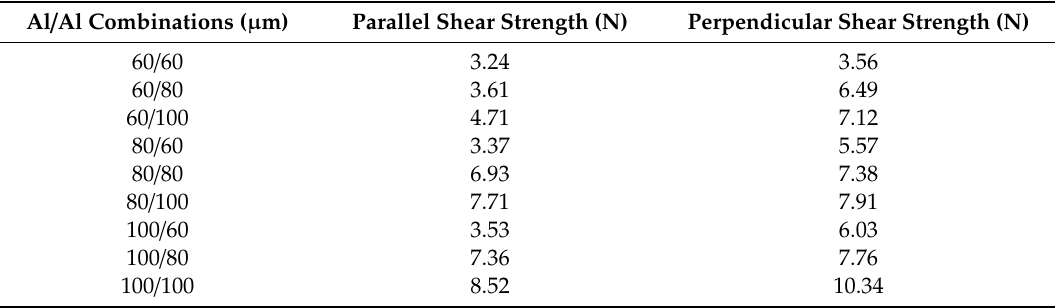
Table 10. The parallel and perpendicular shear strength of tested Al / Al combinations. Al / Al Combinations ( µ m) Parallel Shear Strength (N) Perpendicular Shear Strength